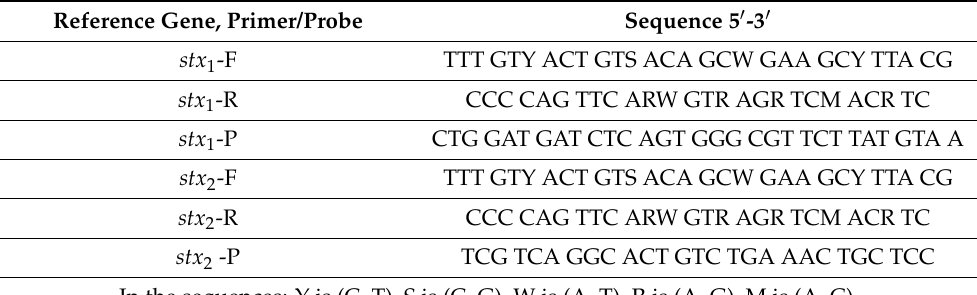
Table 1. Primer and probe sequences used in this study